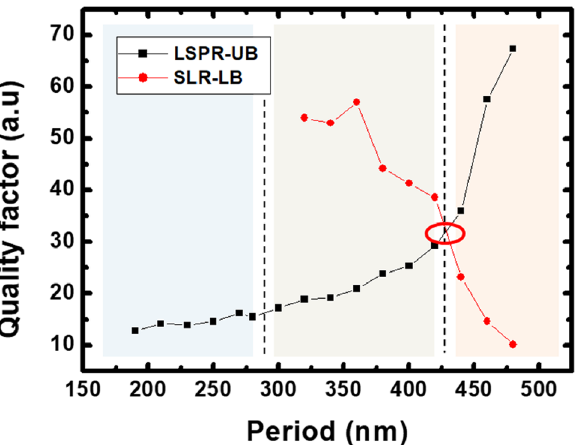
Figure 3. The quality factor associated to the principal resonance (LSPR-UB) and the excited narrow peak (SLR-LB) as a function of the period. Three zones can be distinguished p ≤ 280 nm, 280 nm < p ≤ 430 nm and p > 430